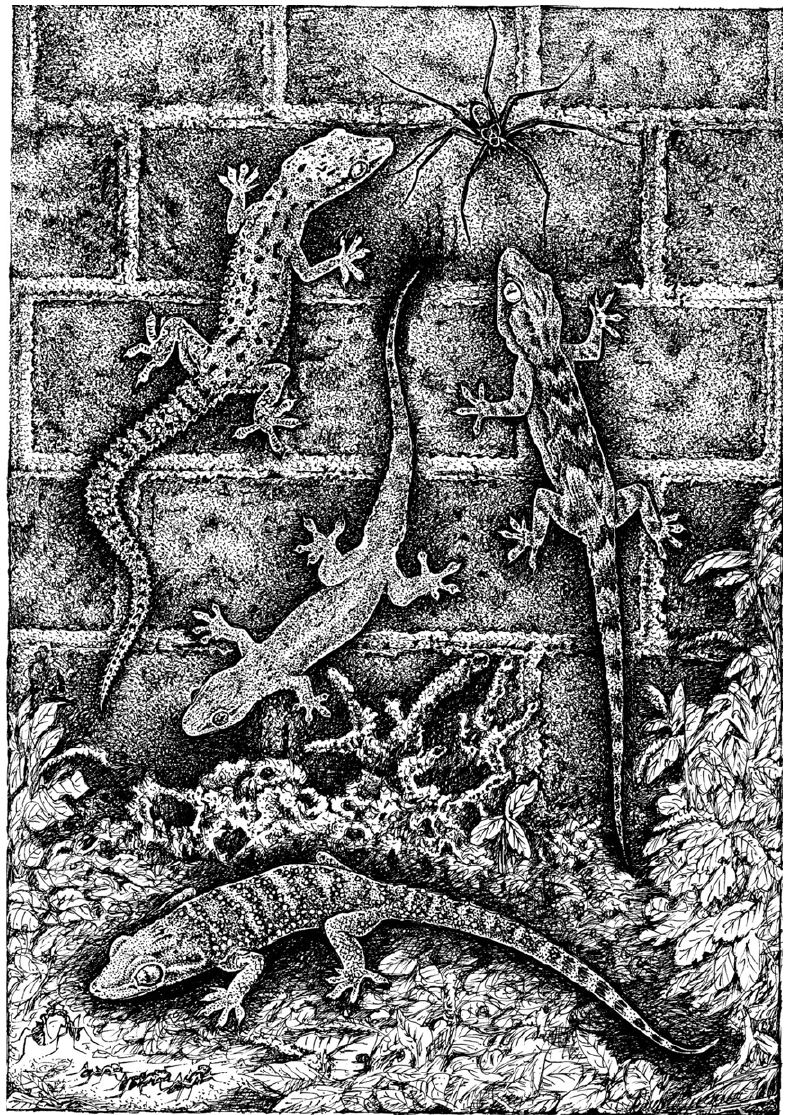
Image 9. Brook’s Gecko Hemidactylus brookii , Bark Gecko H. leschenaultii , Southern House Gecko H. frenatus and Termite Hill Gecko H. triedrus . Drawn using technical pen (Rotring .10, .20 and